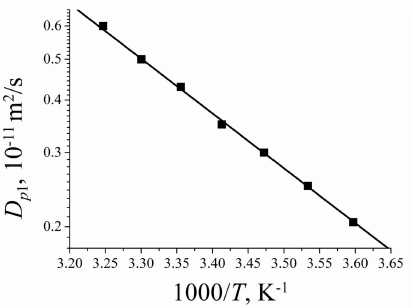
Figure 63. A temperature dependence of the hindered water self-diffusion coefficient D p . The solid straight line is the Arrhenius equation approximation. The activation energy is 24.1 ± 1.9 kJ/mol. Reprinted with permission from [171]. Copyright 2016 Springer